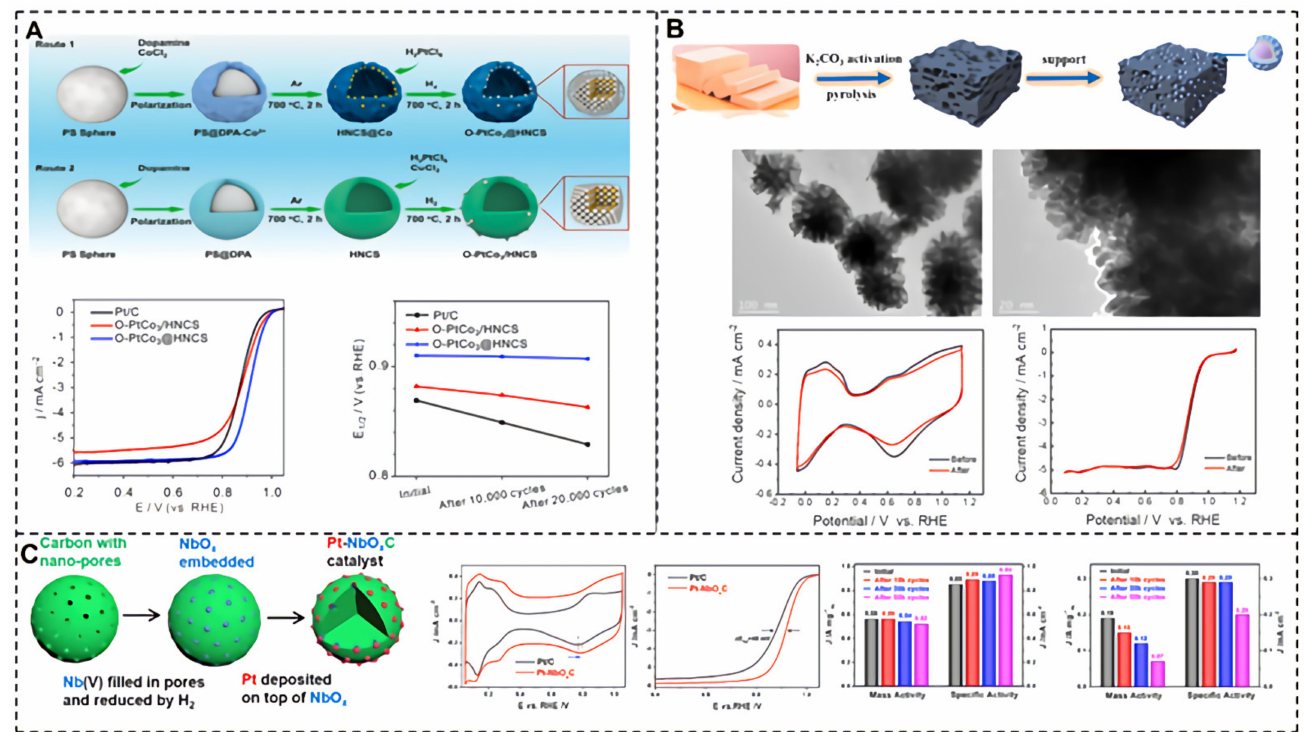
Figure 2. ( A ) Elementary diagram of the synthesis of O-PtCo3@HNCS and O-PtCo3/HNCS and electrocatalytic properties of Pt/C, O-PtCo3/HNCS, and O-PtCo3@HNCS [20]. ( B ) Elementary diagram of the Au@Pd@Pt-NSC catalysts and the TEM images, CV curves, polarization curves of the Au@Pd@Pt-NSC-900 material [21]. ( C ) Schematic illustration of Pt/metal oxide/carbon composite catalyst (Pt-NbOxC) and cyclic voltammetry curves, ORR polarization curves